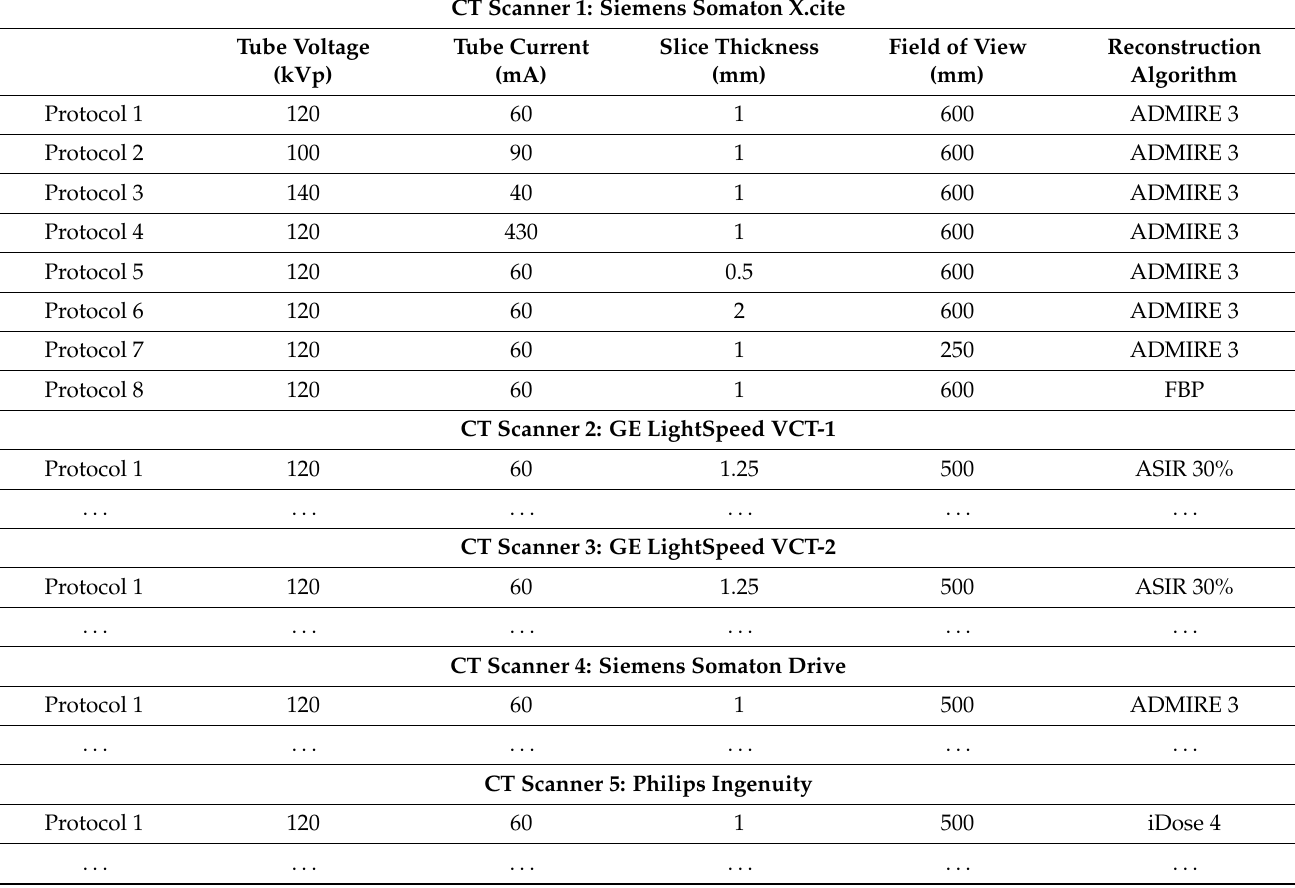
Table 1. Parameters for the different CT acquisitions. Eight protocols were performed for each of the five scanners.